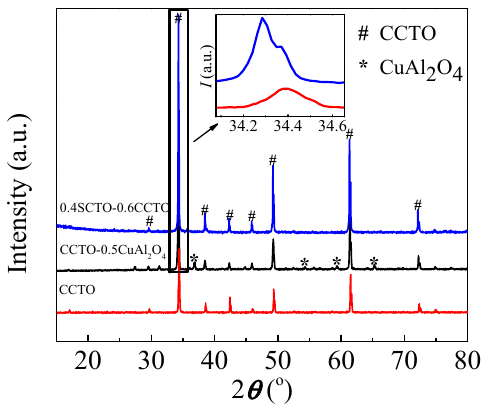
Figure 1. XRD patterns of undoped CCTO ceramics, the CaCu 3 Ti 4 O 12 -0.5CuAl 2 O 4 composite, and the 0.4 SrCu 3 Ti 4 O 12 -0.6 CaCu 3 Ti 4 O 12 composite. Inset is the magnification of main peak for CCTO and 0.4 SrCu 3 Ti 4 O 12 -0.6 CaCu 3 Ti 4 O 12 . Microstructures of CCTO-0.5CuAl 2 O 4 and 0.4SCTO-0.6CCTO ceramics and pure CCTO in